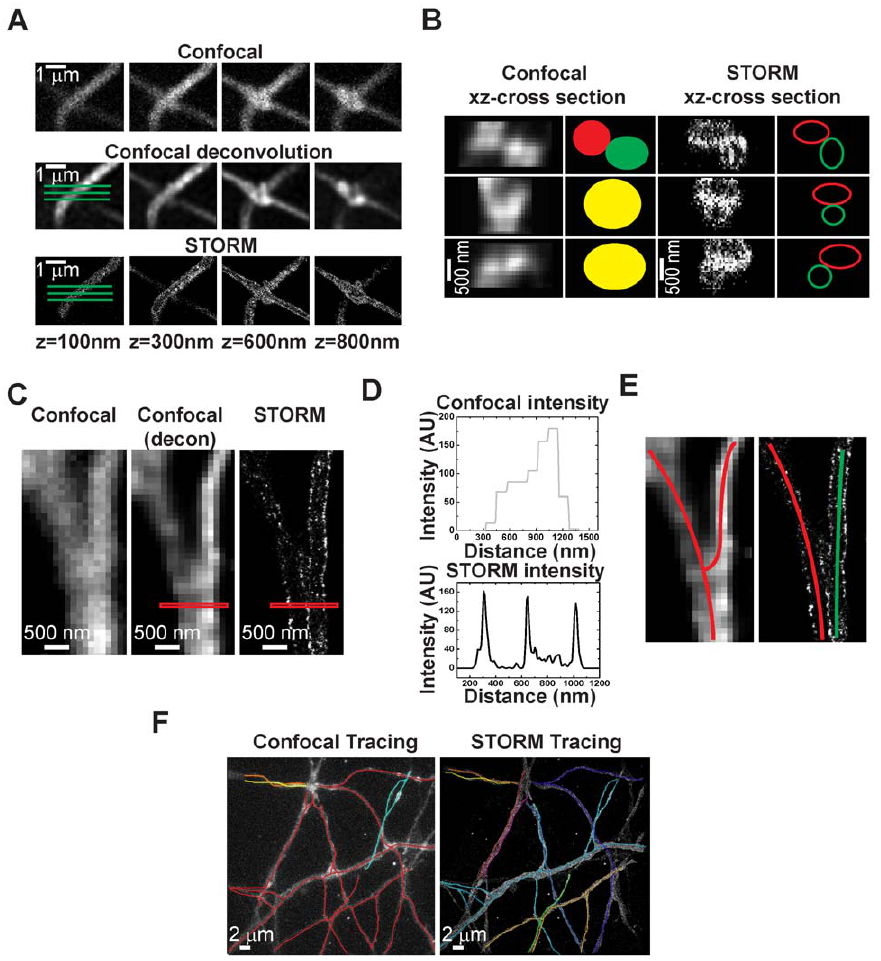
Figure 3. Tracing of hippocampal neurons. (A) Z-stack showing two neural processes that cross each other at different heights in confocal ( upper panels ), confocal after deconvolution ( middle panels ), and STORM ( lower panels ). (B) The xz cross-sections are plotted across the three green lines in ( A ) for the confocal image after deconvolution ( left ) and the STORM ( right ) image. The xz cross-section of the ‘‘top’’ and ‘‘bottom’’ neural processes cannot be easily discerned in the confocal images at the crossing point ( left ) as they merge together. Thus the two neural processes (red and green circles ) appear to merge into one process ( yellow circles ). On the other hand, the membrane that separates the two neural processes is clear in the STORM cross-sections and a ‘‘top’’ ( red oval ) and ‘‘bottom’’ ( green oval ) neural process can be identified at all locations. (C) xy cross-section taken from the midpoint image of a 3D confocal ( left ) and STORM stack ( right ). The middle panel shows the confocal slice after deconvolution. (D) The graphs show the intensity profile across the red rectangle shown in ( C ) for the confocal image after deconvolution ( grey plot ) and the STORM ( black plot ) image. Three clearly separable peaks are seen in the STORM plot. The first peak is the membrane edge of the first neuron and the last peak is the membrane edge of the second neuron. The peak in the middle is the membrane boundary that separates the two neurons. (E) The difference in tracing results for this region in confocal ( left ) and STORM ( right ). The confocal tracing leads to one parent process splitting into two branches ( red ) whereas the STORM tracing leads to two neural processes ( red and green ) in close proximity. (F) Tracing results for an identical region of neurons in confocal ( left ) and STORM ( right ). Distinct processes are assigned different colors.